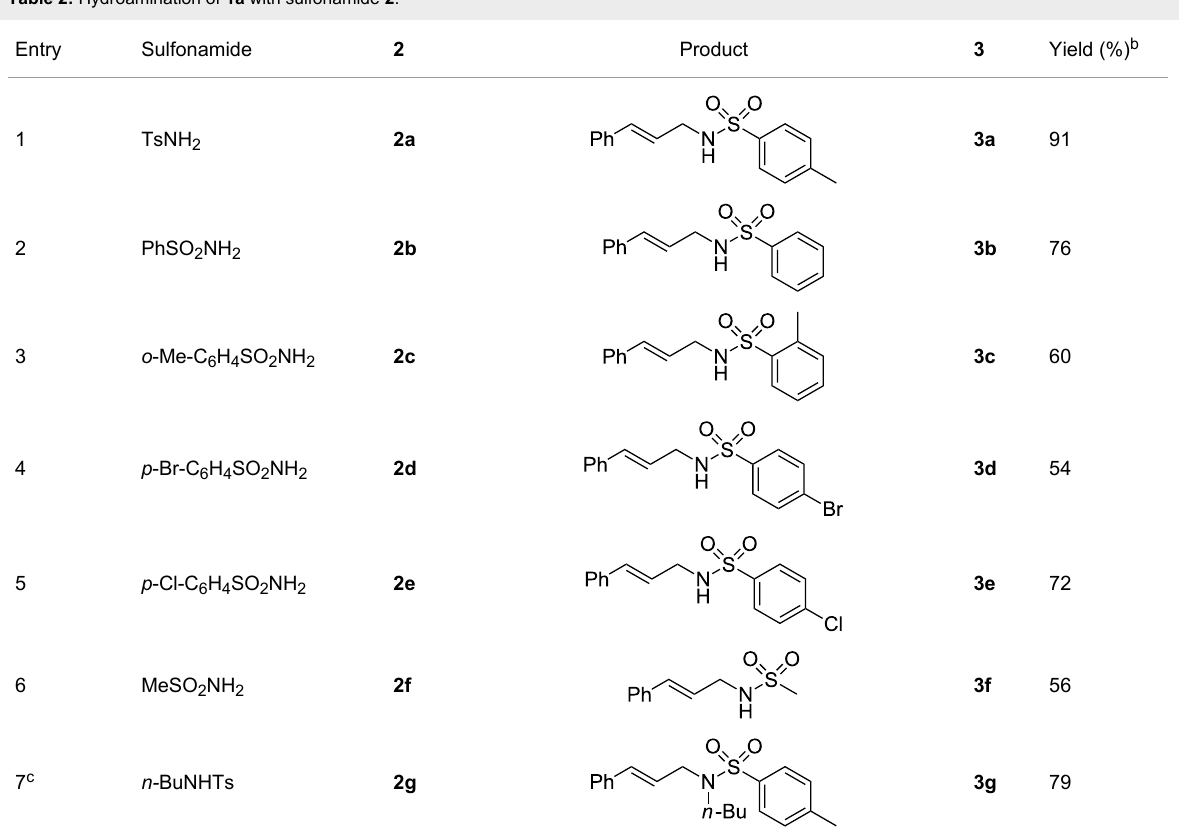
Table 2: Hydroamination of 1a with sulfonamide 2 . a